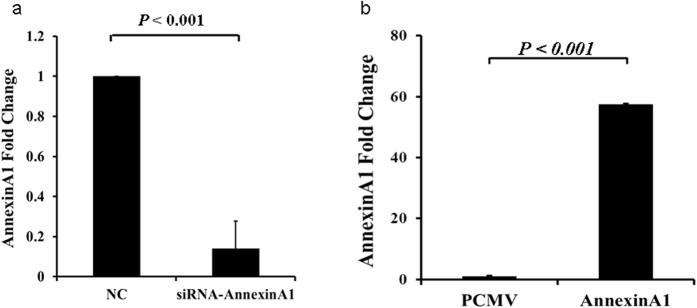
Realtime PCR analysis of Annexin A1 expression.(a) Annexin A1 mRNA level was reduced in AGS cells transfected with Annexin A1 siRNA compared to NC. (b) Annexin A1 mRNA level increased in AGS cells transfected with Annexin A1 expression plasmid compared to cells transfected with vector alone.